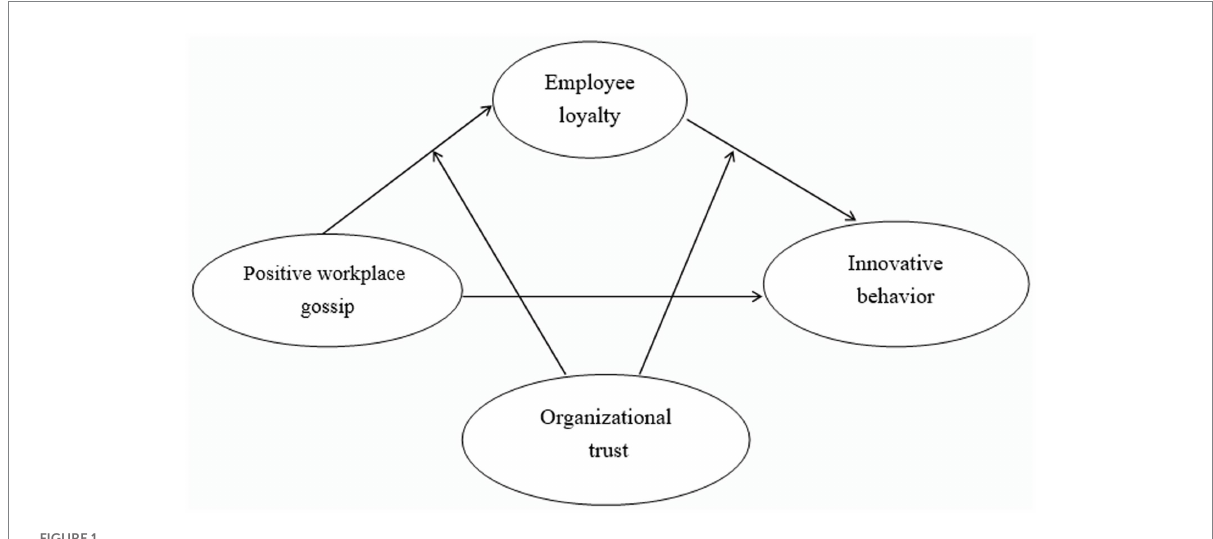
FIGURE 1 Hypothesized